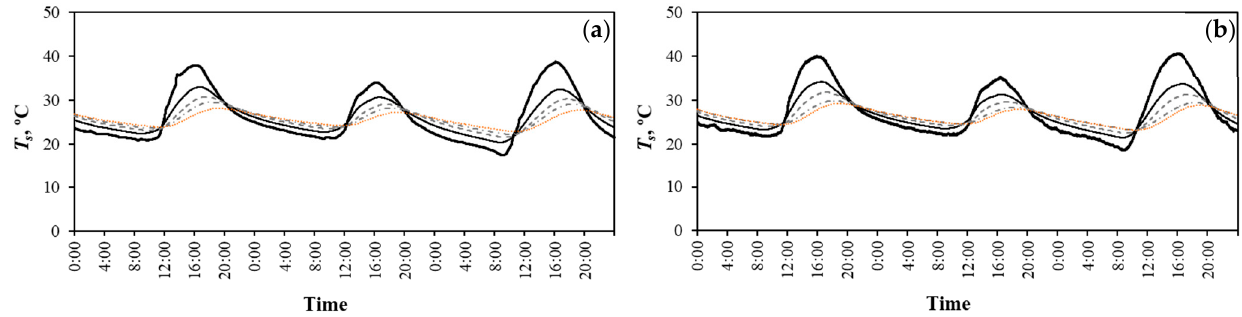
Figure 3. Temperature in the zone without low tunnel ( a ) and in the zone with low tunnel ( b ) measured from the 3 to 5 March 2015: air temperature at 2 m ( ─ ), at 1 m ( ‐‐‐ ) and at 0.2 m ( ‐∙‐ ) in height; outside air temperature ( ▬ ); plant leaves temperature ( ∙∙∙ ). Figure 6. Soil temperature without low tunnel ( a ) and with low tunnel ( b ) measured from the 3 to 5 March 2015: at 0 m ( ▬ ), 0.05 m ( ─ ), 0.10 m (---), 0.15 (-·-), and 0.20 m ( ··· ) deep.